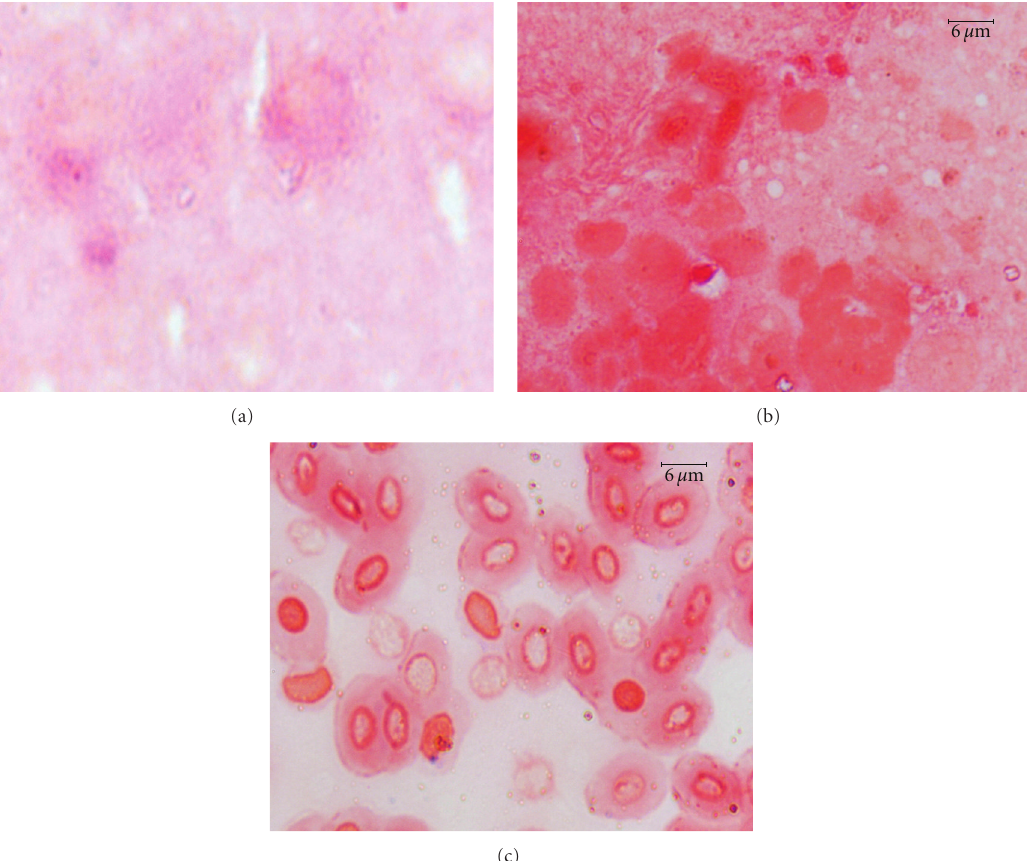
Figure 5: Control slides covered with homogenized carp skin mucus (a), trout liver (b), and carp blood (c): no bacterial cells are